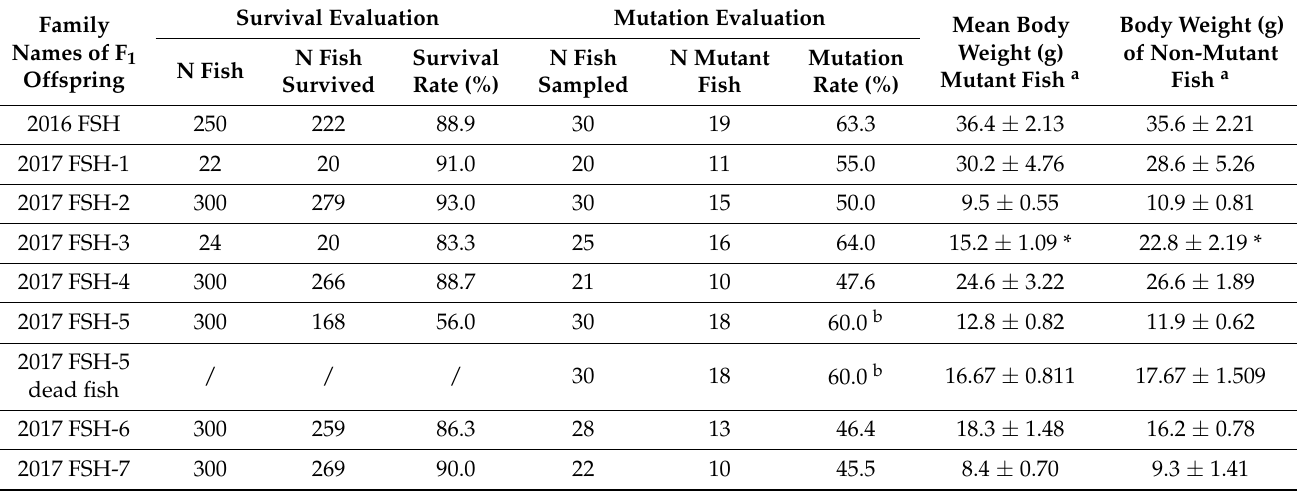
* Mutant fish in the family 2017 FSH-3 had a considerably lower body weight (Student’s t test, p = 0.009) than non-mutant fish in the same family. a The mutant fish and non-mutant fish had no significant differences in body weight in seven F 1 families, including 2016 FSH ( p = 0.807), 2017 FSH-1 ( p = 0.827), 2017 FSH-2 ( p = 0.156), 2017 FSH-4 ( p = 0.585), 2017 FSH-5 ( p = 0.373), 2017 FSH-6 ( p = 0.223), and 2017 FSH-7 ( p = 0.578) (Student’s t